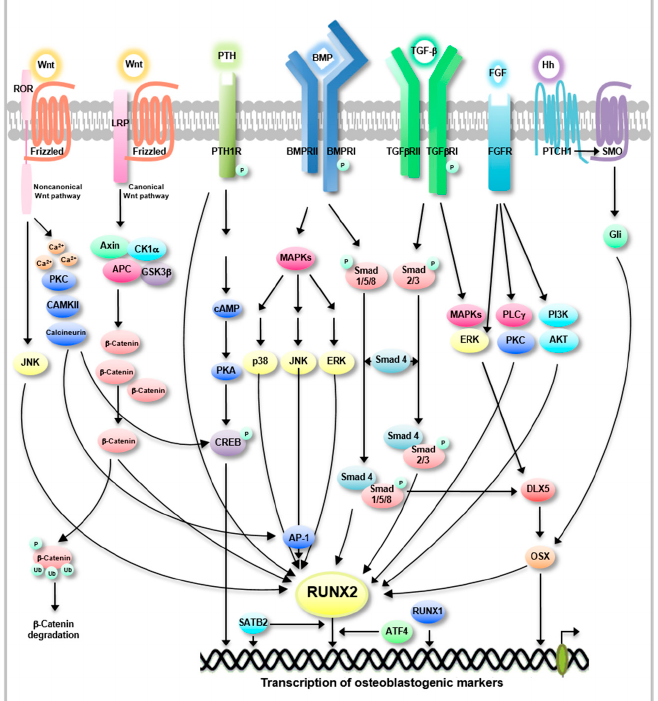
Figure 2. Key signaling pathways in osteoblastogenesis. BMP, bone morphogenetic protein. BMPR, BMP receptor. PTH, parathyroid hormone. PTH1R, PTH receptor 1. TGF- β , transforming growth factor- β . TGF β R, TGF- β receptor. FGF, fibroblast growth factor. FGFR, FGF receptor. Hh, hedgehog. PTCH1, patched 1. SMO, smoothened. RUNX1/2, runt-related transcription factor 1/2. OSX,